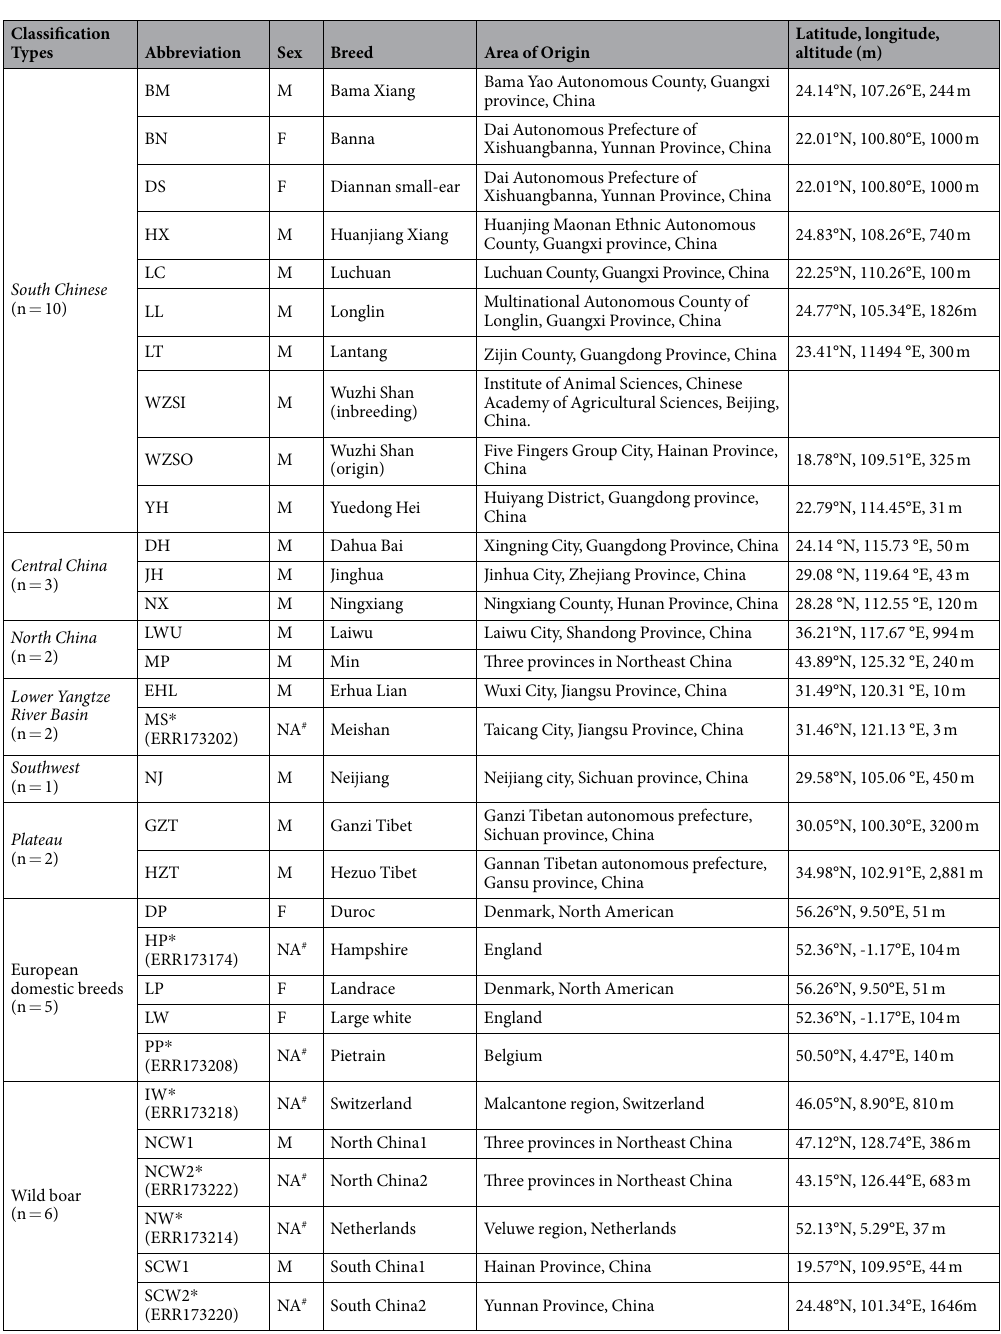
Table 1. Summary of the sample information. Notes: (1) * Downloaded data of seven individuals (one pig per breed) from the Wageningen University Porcine re-sequencing Phase 1 Project (https://www.ebi.ac.uk/ena/ data/view/PRJEB1683). (2) # NA represents